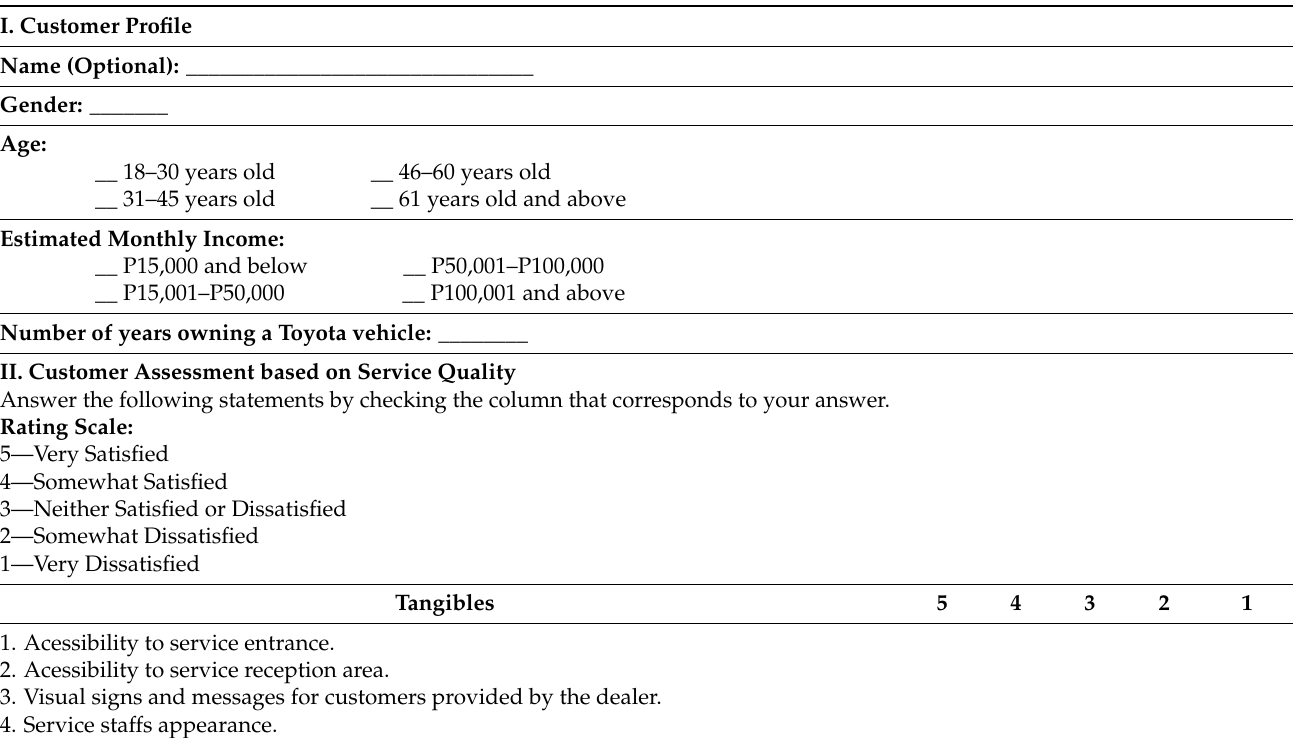
Table A1. Sample Survey